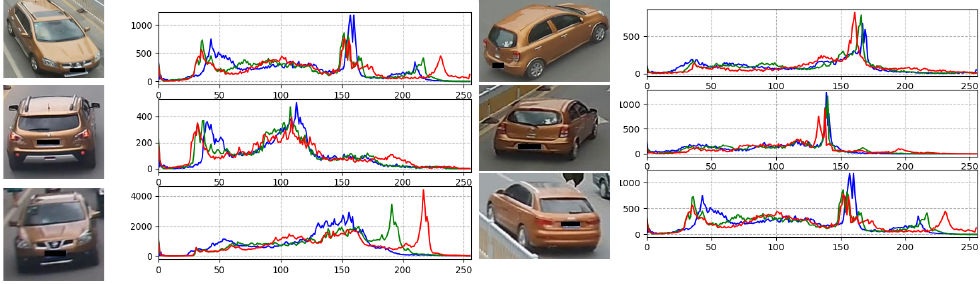
Figure 1. ( a ) Illustration of the RGB color histogram distributions of the same vehicle. ( b ) Illustration of the RGB color histogram distributions of different vehicles. Different color lines denote different channels in RGB